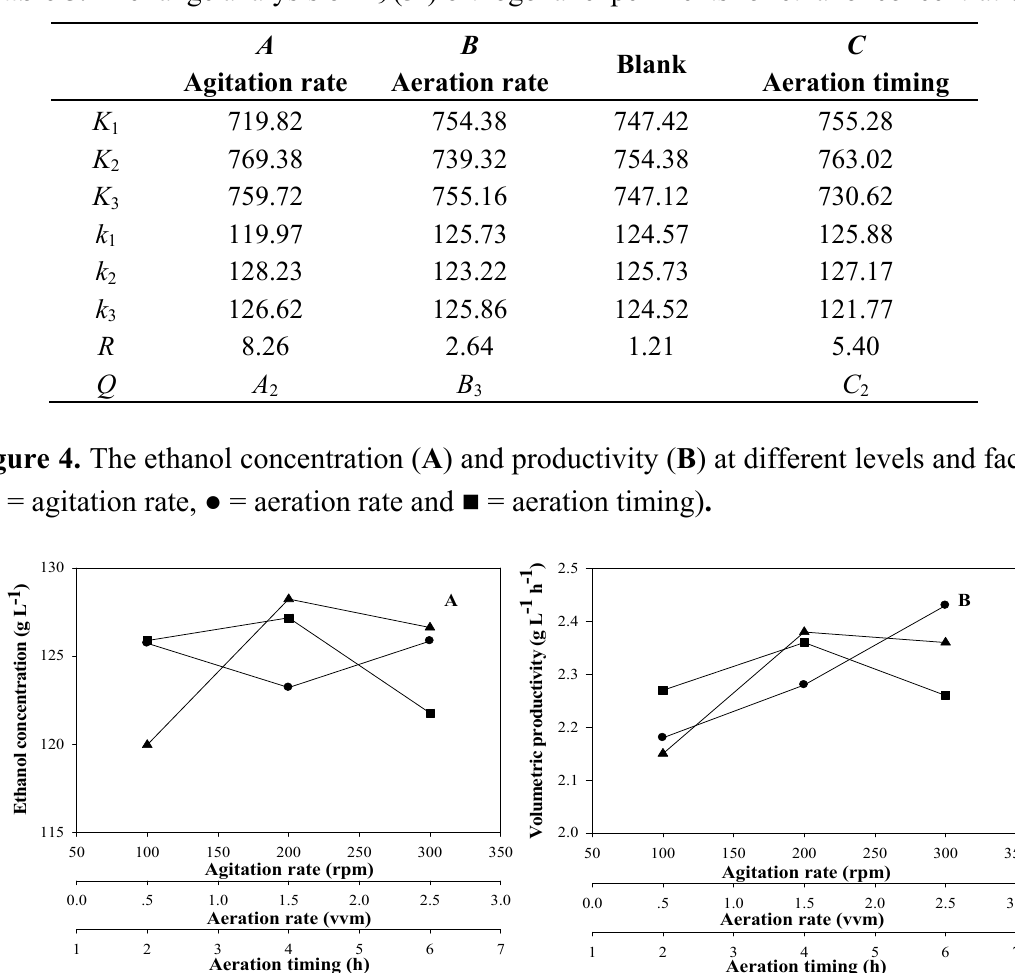
Table 5. The range analysis of L